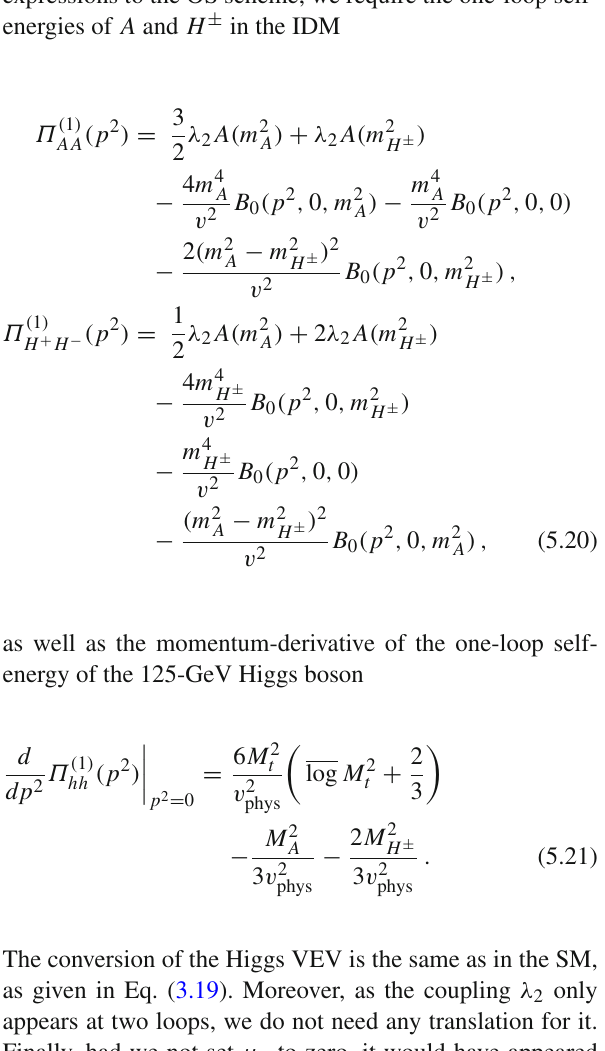
MS to OS scheme conversion – For the translation of these expressions to the OS scheme, we require the one-loop self- energies of A and H ± in the